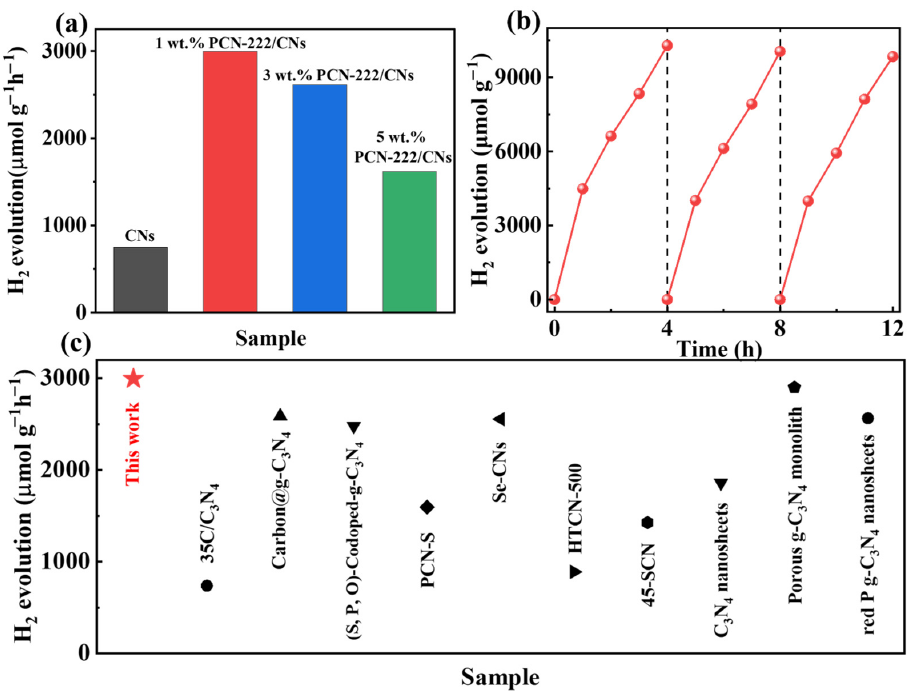
Figure 5. ( a ) Photocatalytic hydrogen production activity of CNs and PCN-222/CNs. ( b ) Cycling tests of 1 wt.% PCN-222/CNs. ( c ) Hydrogen production rate of some reported catalysts [41–50].